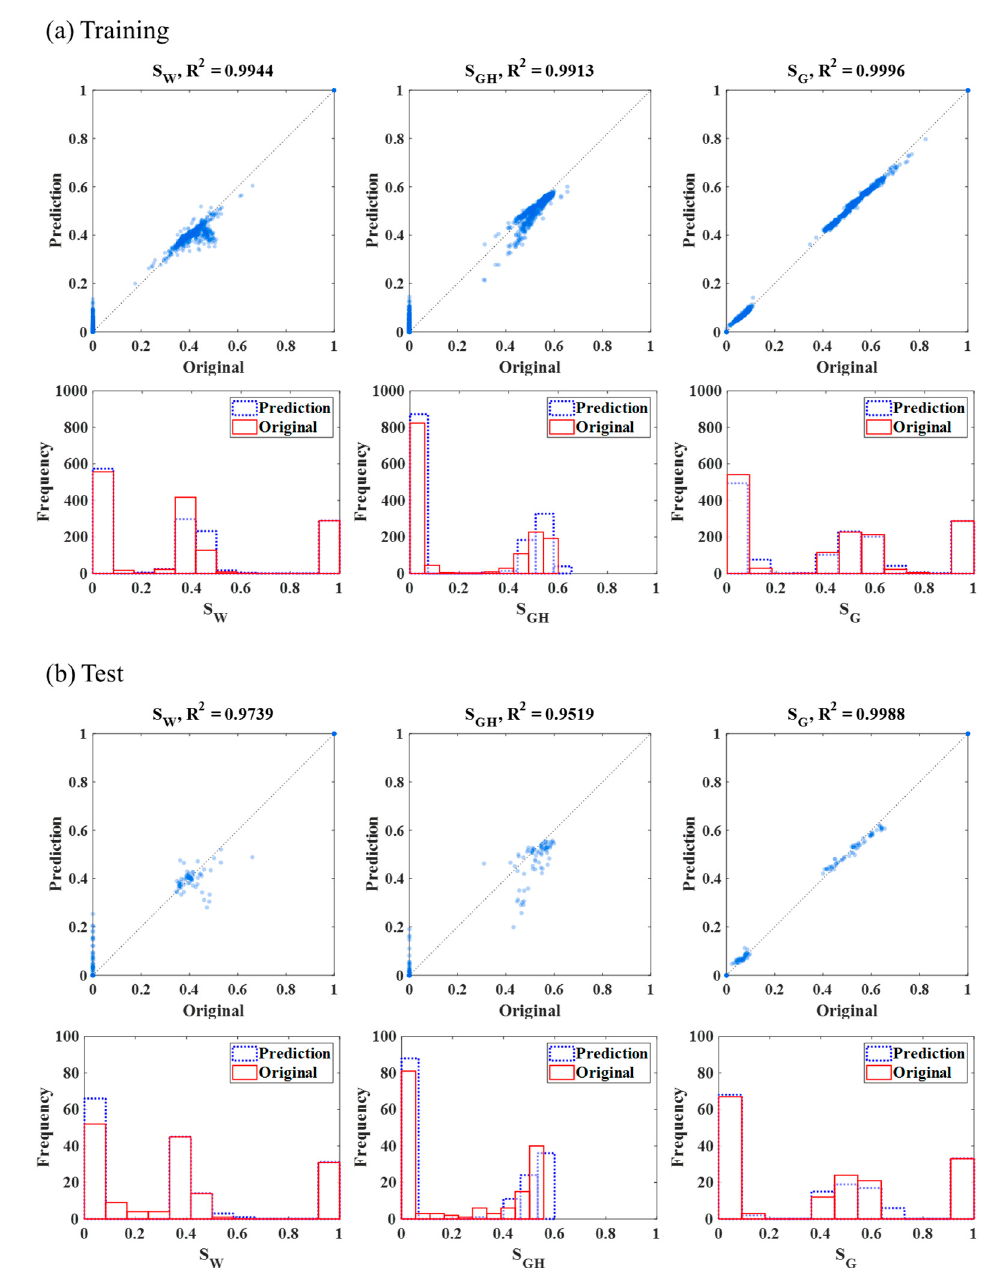
Figure 11. ( a ) Training and ( b ) test results of Case 3, each column means each saturation, water, gas hydrate, and gas with coefficient of determination. In the scatter plots, the X and Y axes indicate the given original data and the predicted value by random forest, respectively. In the histogram pictures, the X and Y axes mean each saturation and frequency, respectively.